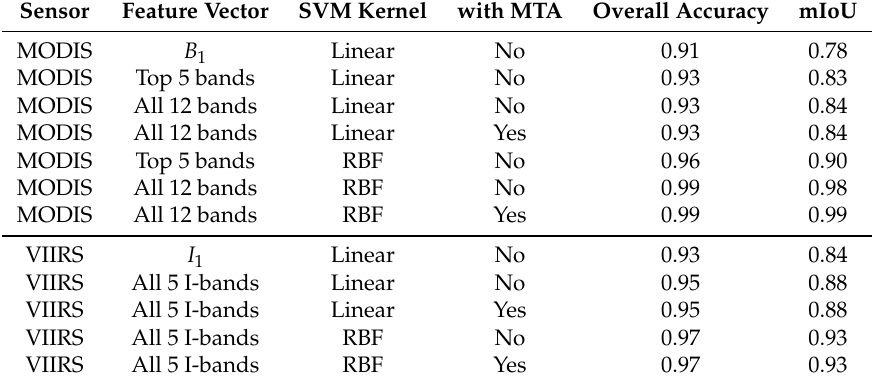
Table 7. The 4-fold cross validation results on MODIS and VIIRS data from two winters (16–17 and 17–18). For the same SVM setup, results without and with multi-temporal analysis (MTA) are shown.